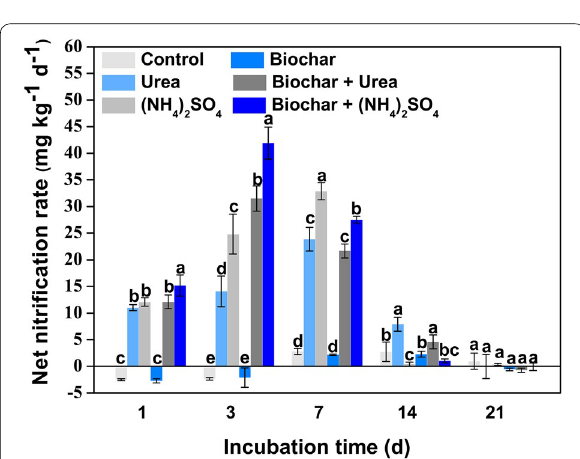
Fig. 2 Dynamics of net nitrification rate after the application of bio‑ char and nitrogen fertilizer in the greenhouse vegetable